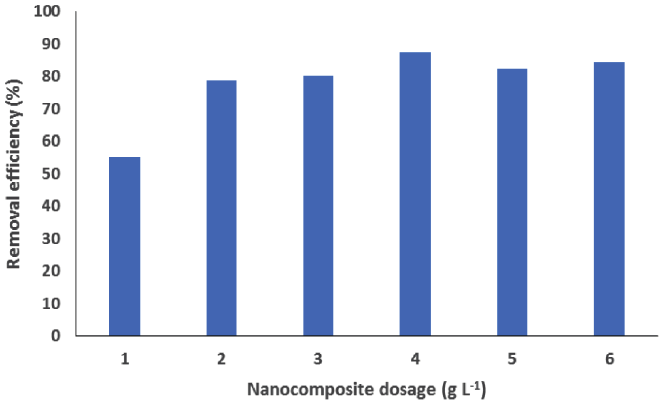
/AC nanocomposite dos- 2